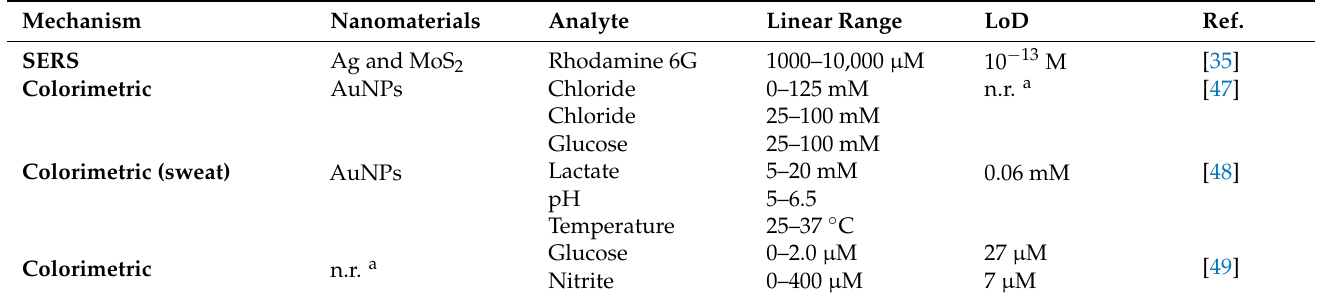
Table 1. Summary of various commercially available wearable optical